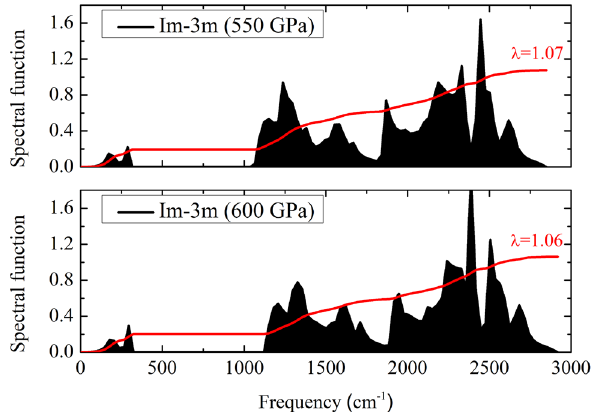
Figure 4. The Eliashberg spectral function and the integrating of lambda are calculated at 550 GPa and 600 GPa in the sodalite-like clathrate hafnium hexahydride structure.